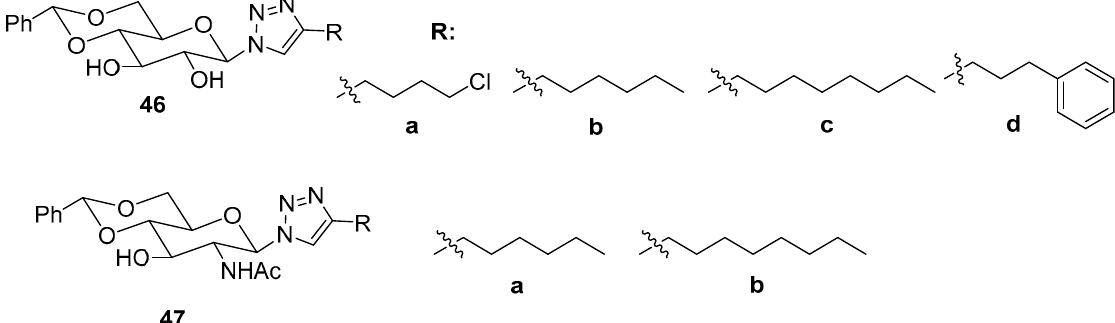
Figure 32. Structures of the benzylidene acetal protected β -triazolyl glucosides as gelators [79].